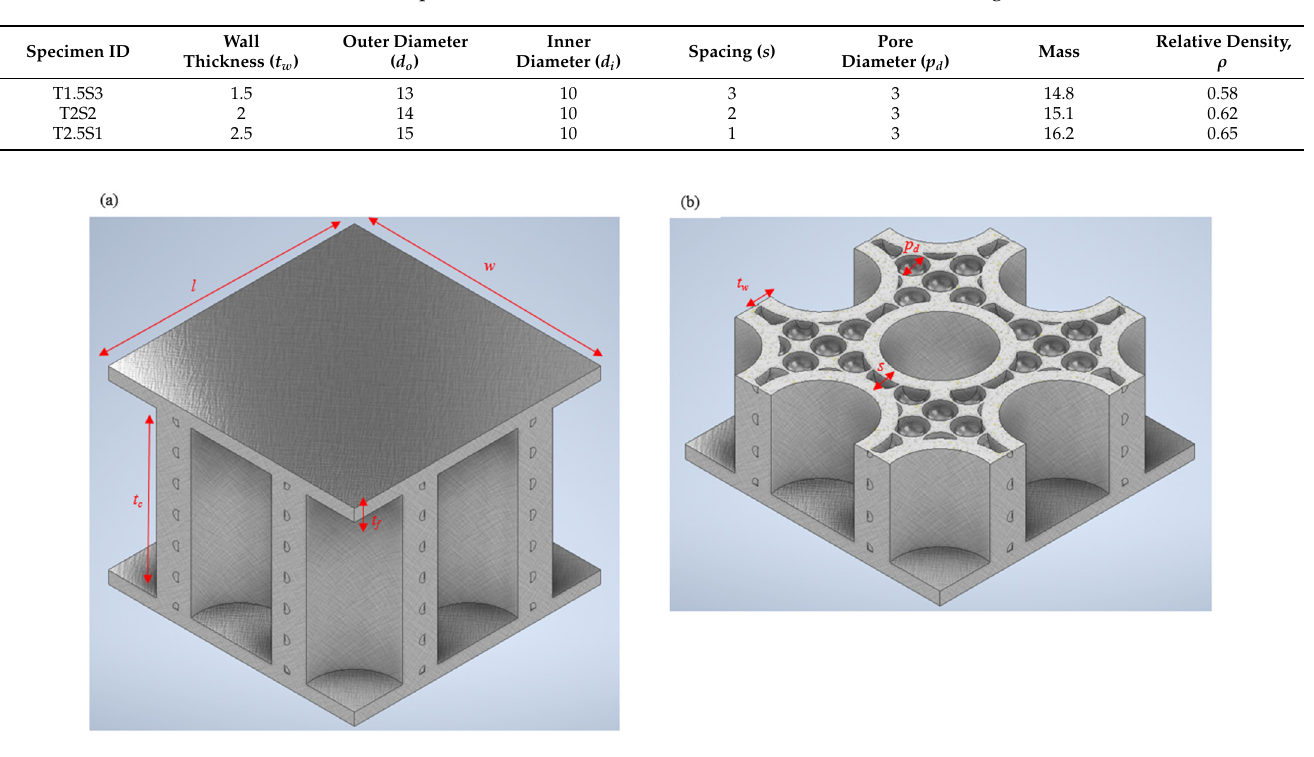
Figure 2. CAD model and geometric configuration of the biomimetic porous sandwich structure. Figure 2. ( a ) CAD model and ( b ) geometric configuration of the biomimetic porous sandwich Table 1. Geometrical parameters of the sandwich structures (units: mm).